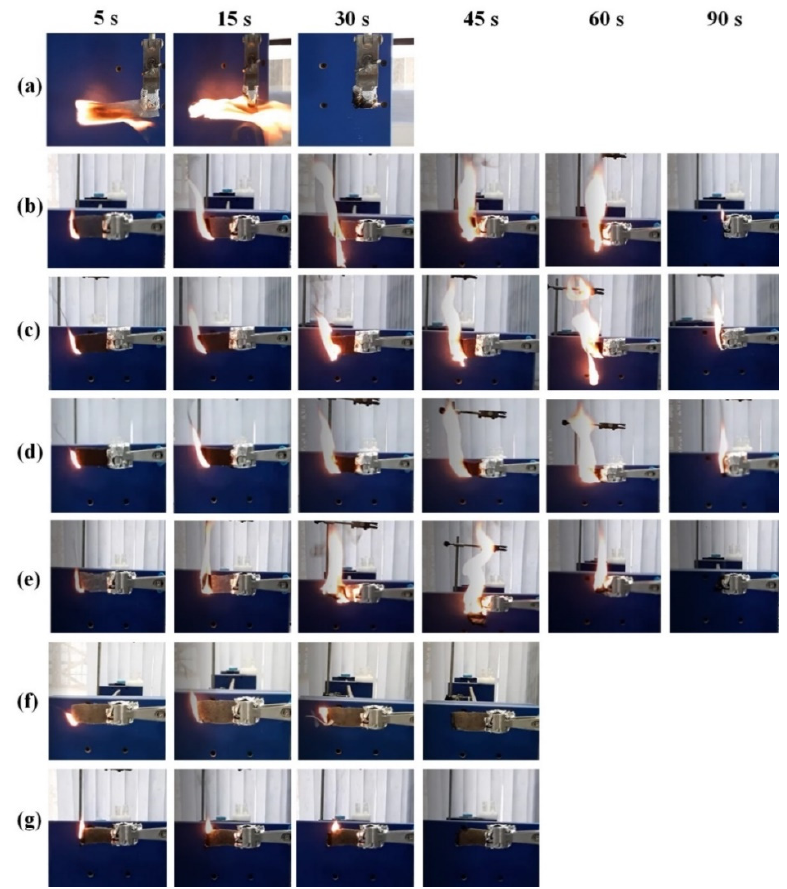
Figure 10. Snapshots taken from videos showing the evolution of flame propagation as a function of time in a horizontal flame test configuration; ( a ) Ep., ( b ) Ep./Coffee5, ( c ) Ep./Coffee15, ( d ) Ep./Coffee30, ( e ) Ep./P-coffee5, ( f ) Ep./P-coffee15, ( g ) Ep./P-coffee30.